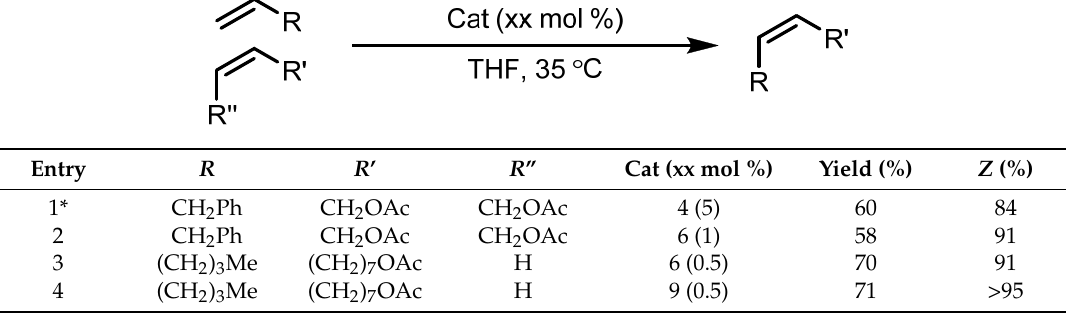
Table 3. CM of allylically substituted olefins using 9 .